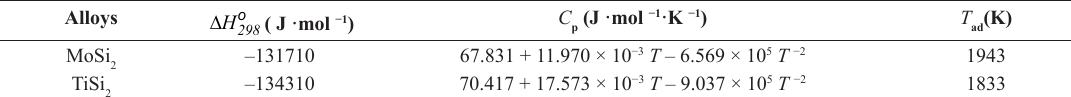
Table 1. The thermodynamics and adiabatic temperature data of MoSi Alloys